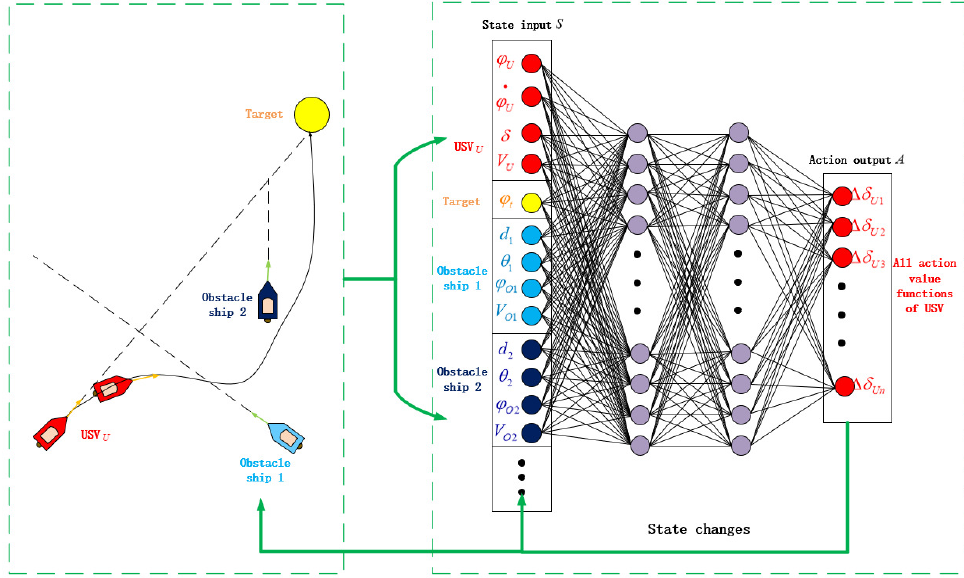
Figure 9. The training process of the USV agent with the reinforcement learning